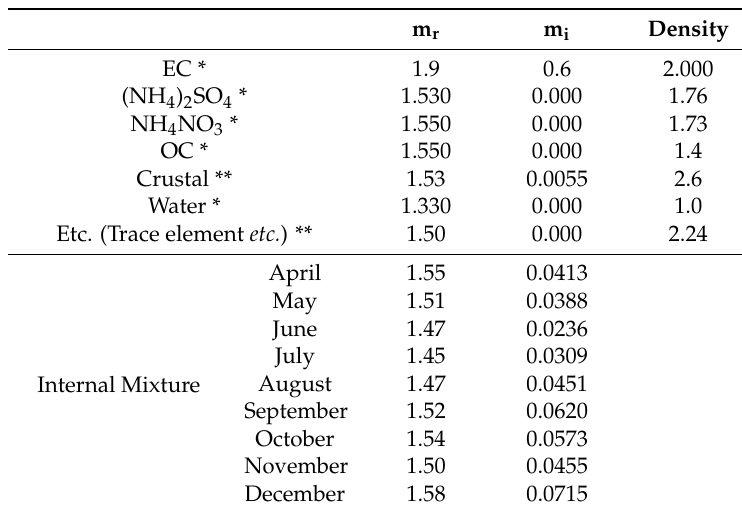
Figure 2. Monthly averaged ion, crustal and carbon concentration contribution by composition in PM 2.5 . Table 1. The refractive index and density of particles.